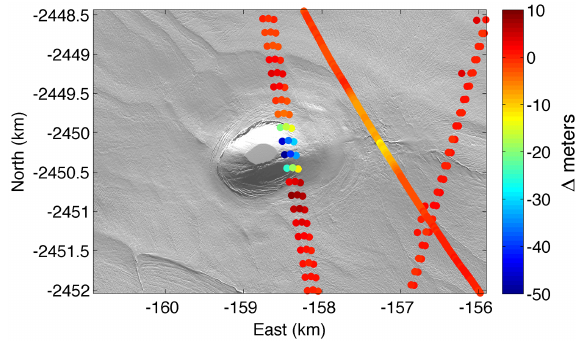
Figure 2. WorldView-1 panchromatic satellite image from 28 Oc- tober 2011, with (dots) 2005 ICESat-1 and (curve) 1993 Airborne Topographic Mapper lidar tracks overlain. Colors are the difference between the 2011 WorldView DEM and earlier lidar elevations. The November 2005 ICESat track is the westernmost track, running closest to the center of the depression. The map coordinates are in polar stereographic projection with a meridian at 70 ◦ W (Worlview image ©2011 DigitalGlobe,